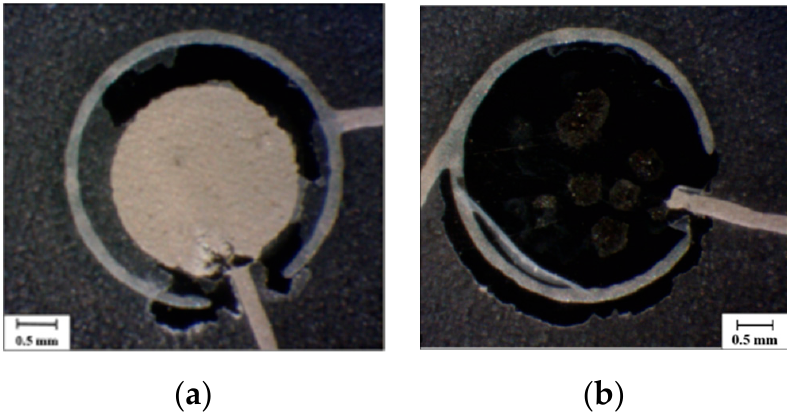
Figure 19. Sensor electrodes have been severely damaged after coupling with adhesive tape all over the skin patch. ( a ) An overall adhesive tape coupled sensor, ( b ) Impaired top electrode of sensor after removing the adhesive tape.